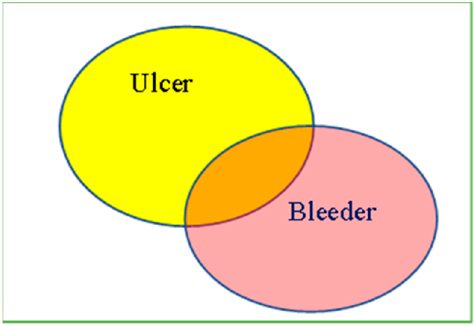
Figure 1. Illustration of Peptic Ulcer Image Processing. The regions of ulcers or bleeders were delineated by two endoscopists. Proportion of Ulcer Area = (Yellow + Orange)/(Yellow + Orang + Pink) × 100%. Proportion of Bleeder Area = (Pink + Orange)/(Yellow + Orang + Pink) × 100%. Proportion of the overlapping area of ulcer/bleeder = (Orange)/(Yellow + Orang + Pink) × 100%.